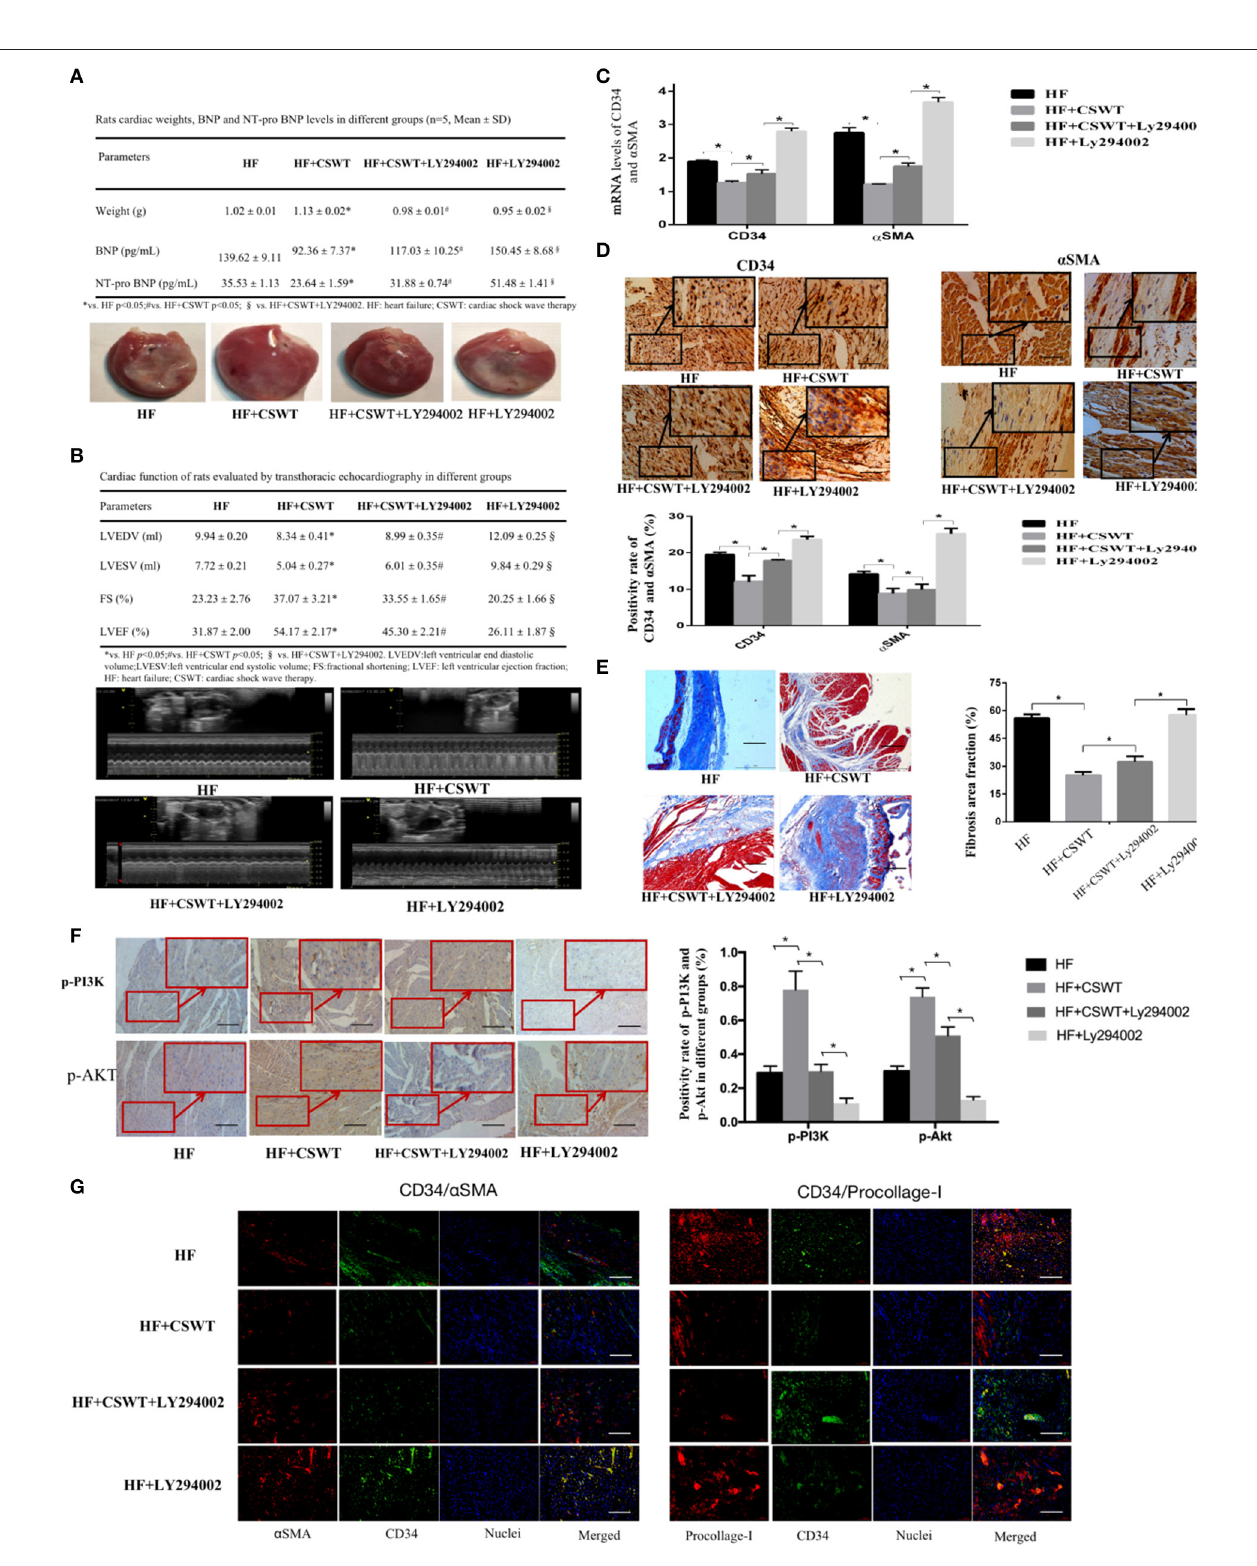
FIGURE 3 | The inhibition of PI3K/Akt pathway abolished the cardiac function improvement and anti-fibrosis effects of CSWT. (A) The cardiac weight, serum levels of BNP and NT-pro BNP and gross view of whole hearts in study groups; (B) Representative M-mode images by echocardiography of rats in study group; (C)